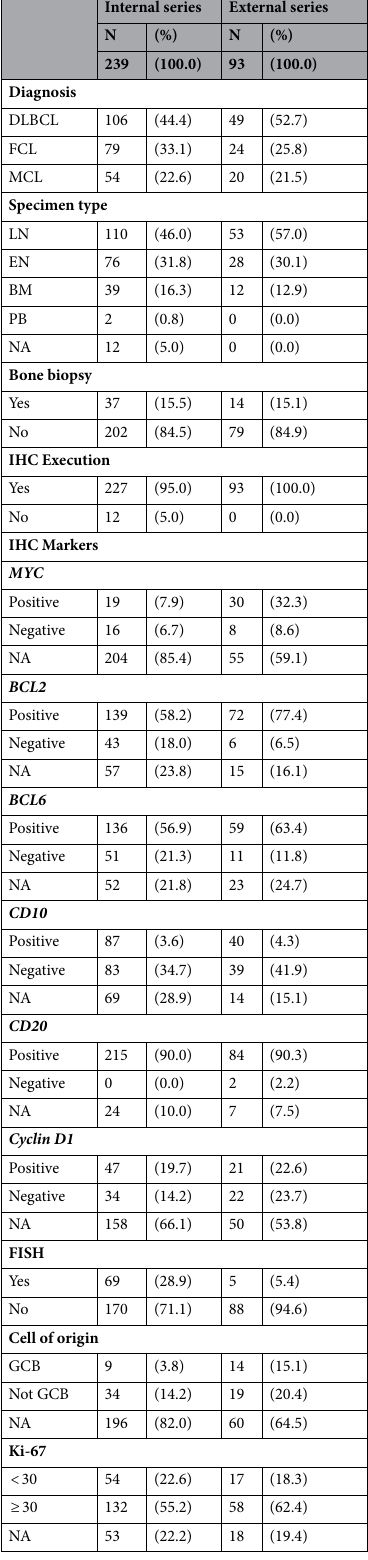
Table 1. Characteristics of pathology reports. ARGO: Automatic Record Generator for Onco-hematology, FCL: Follicular Lymphoma, DLBCL: Diffuse Large B-cell Lymphoma, MCL: Mantle Cell Lymphoma, BM: Bone Marrow, LN: Lymph-Node, EN: Extra-Nodal, PB: Peripheral Blood, NA: Not Available, IHC: Immunohistochemistry, N: number, CD: Cluster of Differentiation, FISH: Fluorescent in situ hybridization, GCB: Germinal Center